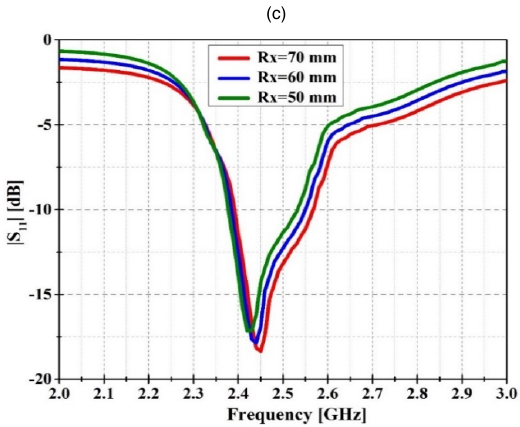
FIGURE 12 . Bending Analysis (a) S11 on several human body parts (b) tested on legs, arm and chest and (c) S11 on various bending angle